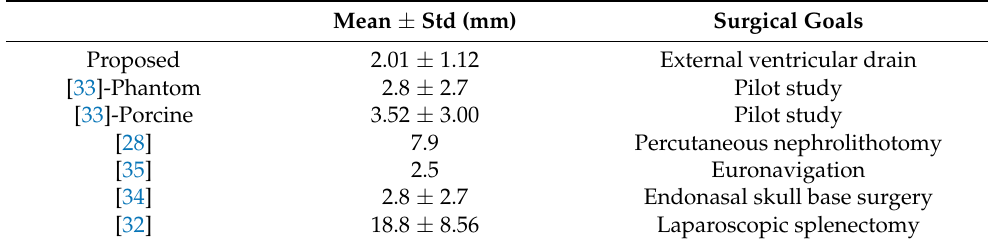
Table 3. Comparison of related